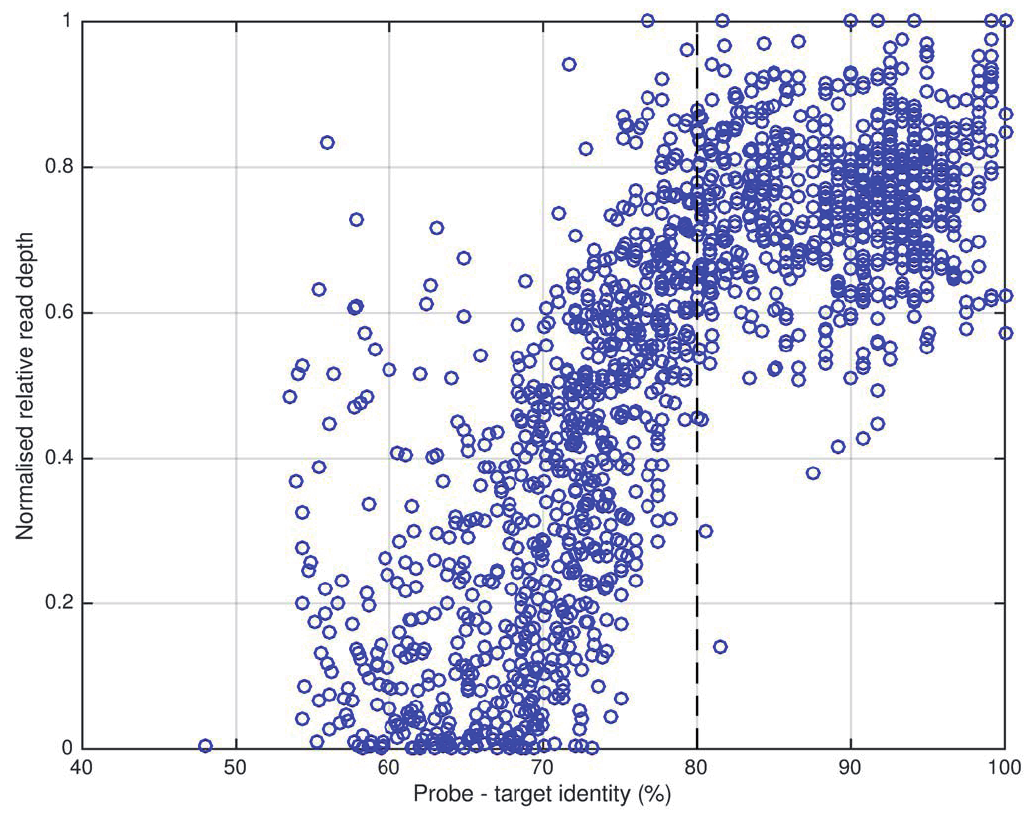
Figure 3. Enrichment efficiency is directly related to probe-target identity. A set of 10 HCV samples with highest VL was sequenced before and after enrichment with a single-genome, subtype 1a probe set, and for each sample the relative read depth for each probe window was plotted against the maximum identity between target and any probe. Read depth ratio was normalized by giving the most efficiently enriched probe position (in the highly conserved 5’ UTR) a value of 1. Maximal enrichment is observed where probe-target identity exceeds approximately 80% and enrichment decreases dramatically as identity falls below